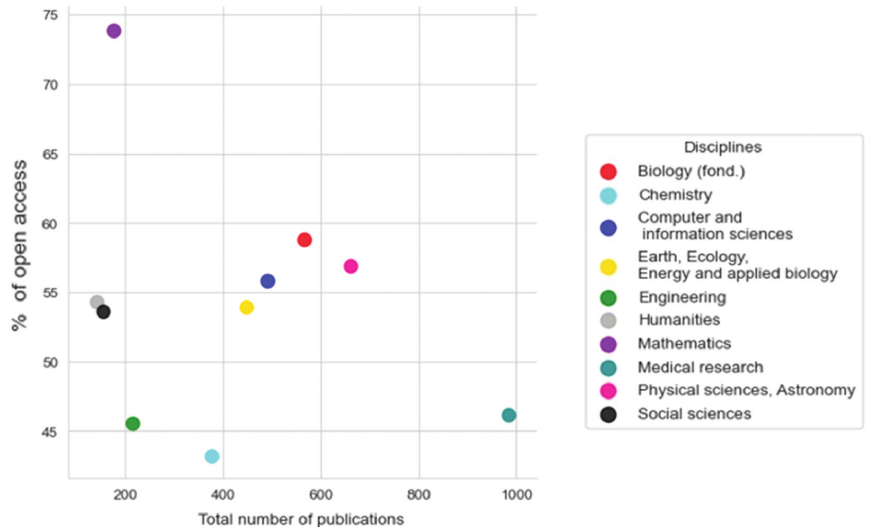
Fig. 3: Open access to publications by discipline related to the number of publications in